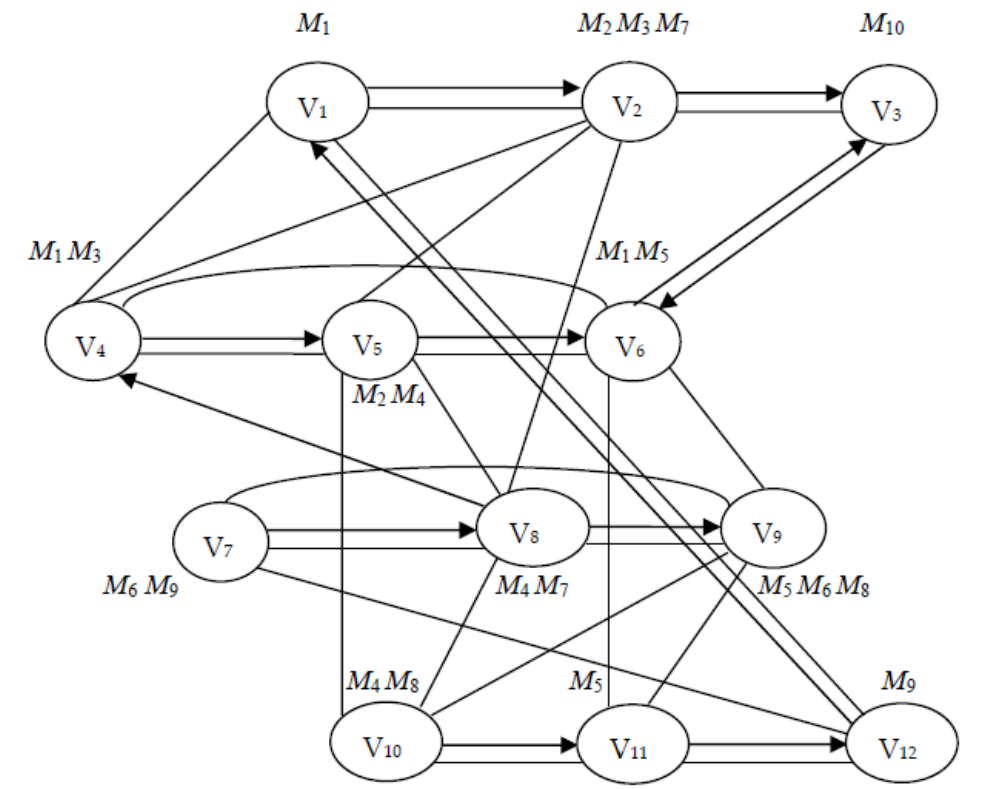
Figure 2. Mixed graph G = ( V , A , E ) determining Example 3 of the general shop scheduling problem GcMPT | t i = 1 | C max with 4 jobs and 10 machines, optimal mixed graph coloring c ( G ) being equivalent to Example